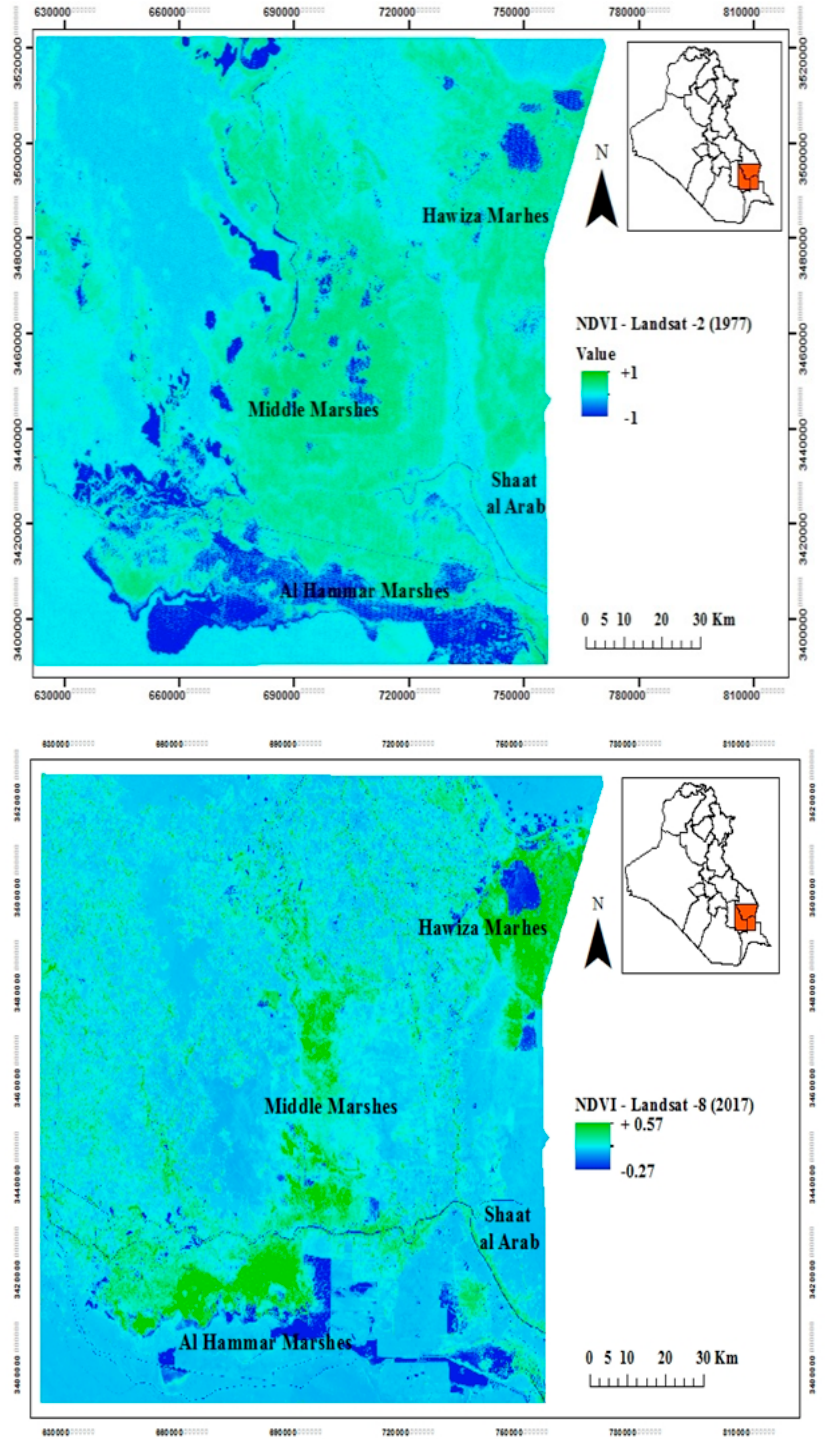
Figure 4. Normalized di ff erence vegetation index (NDVI) values for images of (a) Landsat 2 in 1977, (b) Landsat 8 in 2017 and (c) Sentinel 2 in 2017 for southern Iraqi Marshes sowing the di ff erences between the years 1977 and